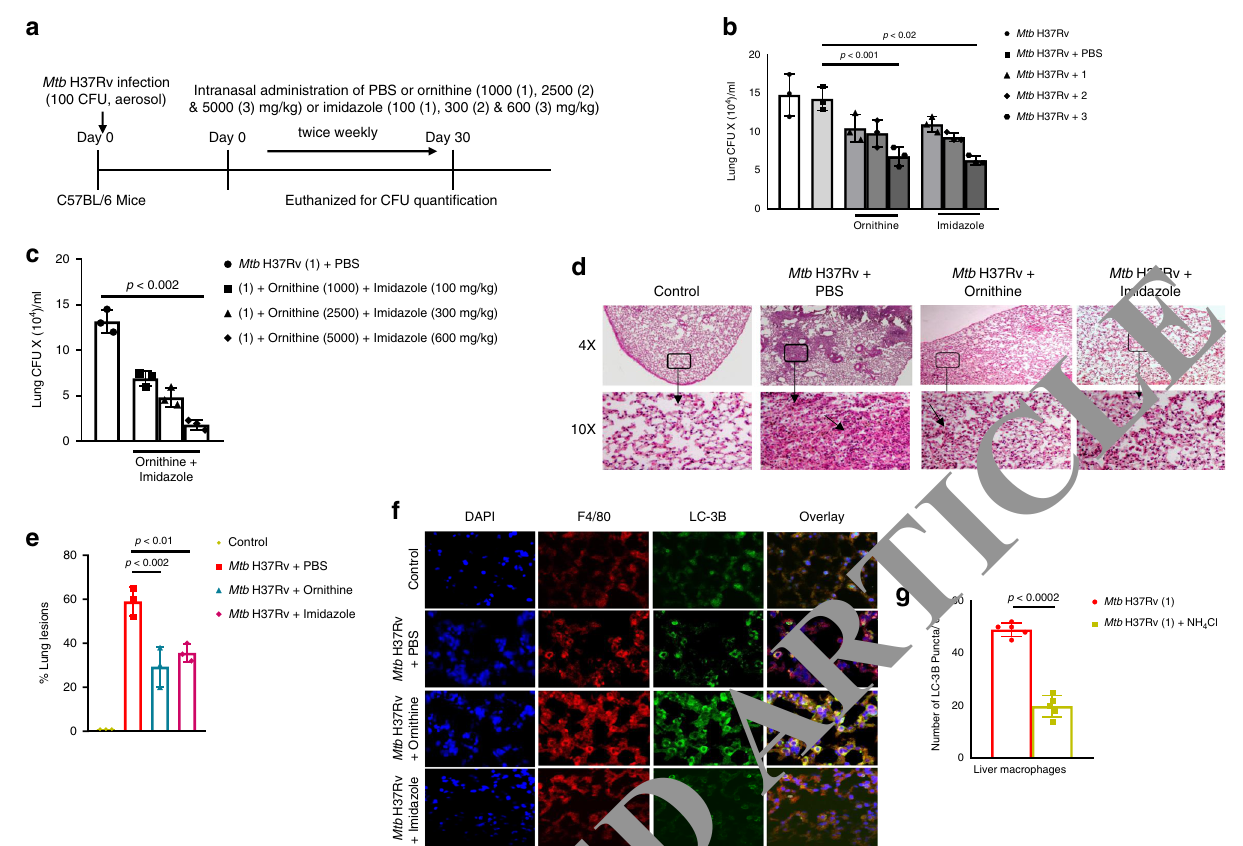
Fig. 7 Ornithine and imidazole restrict Mtb growth in the lungs. C57BL/6 mice were infected with 100 CFU of aerosolized Mtb H37Rv, and then treated with ornithine and imidazole at varying concentrations. a Schematic representation of Mtb infection and intranasal delivery of the compounds. b , c Bacterial burden in the lungs measured after one-month post-infection and post-treatment. Data are representative of three independent experiments ( n = 5 mice per group). Data are expressed as the mean ± SD. p < 0.0015. c Mtb- infected mice were treated in combination of ornithine/imidazole, one group treated with 1000/100mg/kg, other as 2500/300 mg/kg and last group as 5000/600mg/kg. p < 0.0029. d – f At one-month post - infection and post-treatment, the lungs of the uninfected control, Mtb- infected, ornithine or imidazole treated mice were isolated and formalin- fi xed. Paraf fi n-embedded tissue sections were prepared, and hematoxylin and eosin staining was performed. In fl amed lung areas were compared among the groups. d A representative fi gure is shown. e Percentage of the lung lesions was calculated. p < 0.0024, p < 0.0192. f Paraf fi n-embedded lung tissue sections were analyzed by confocal microscopy to evaluate LC-3B (green), F4/80 (far-red) staining as well as their colocalization. Scale bar: 10 μ m. A representative micrograph of LC-3B in lungs is shown. Images of multiple fi elds at 63× magni fi cation were taken with oil immersion. g The immuno fl uorescence intensity (A.U.) of LC-3B are shown. Data are representative of three independent experiments. Five mice per group were used for each independent experiment. p < 0.0013. Statistical analysis was performed using paired two-tailed t test and data are represented as the mean ±